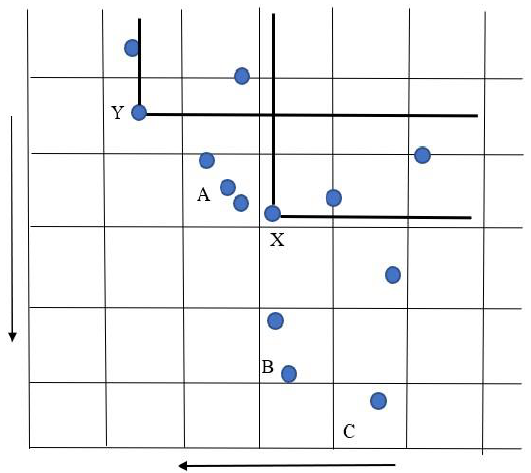
Figure 6. Region-based selection method of Pareto envelope-based selection algorithm (PESA-II).